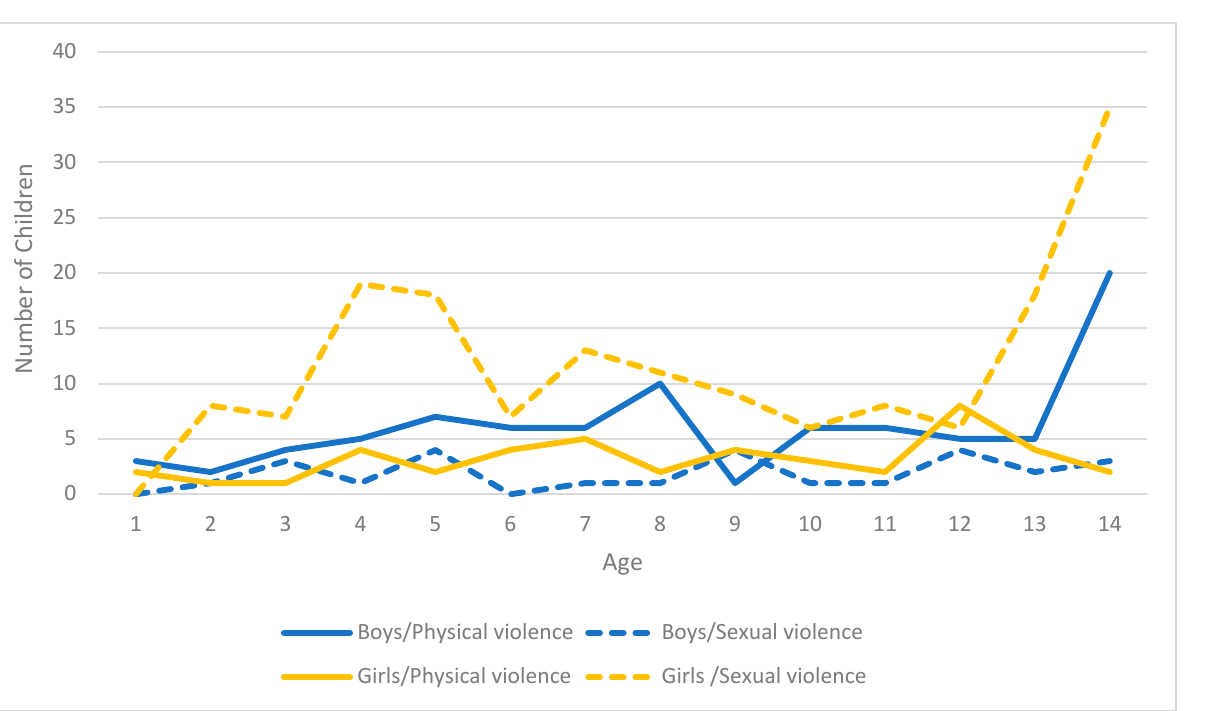
Figure 1. Distribution of the victims of violence-related injuries by age and sex of the child and form of violence, data from pediatric emergency and forensic medicine at MCH, from 1 January to 31 December 2019.